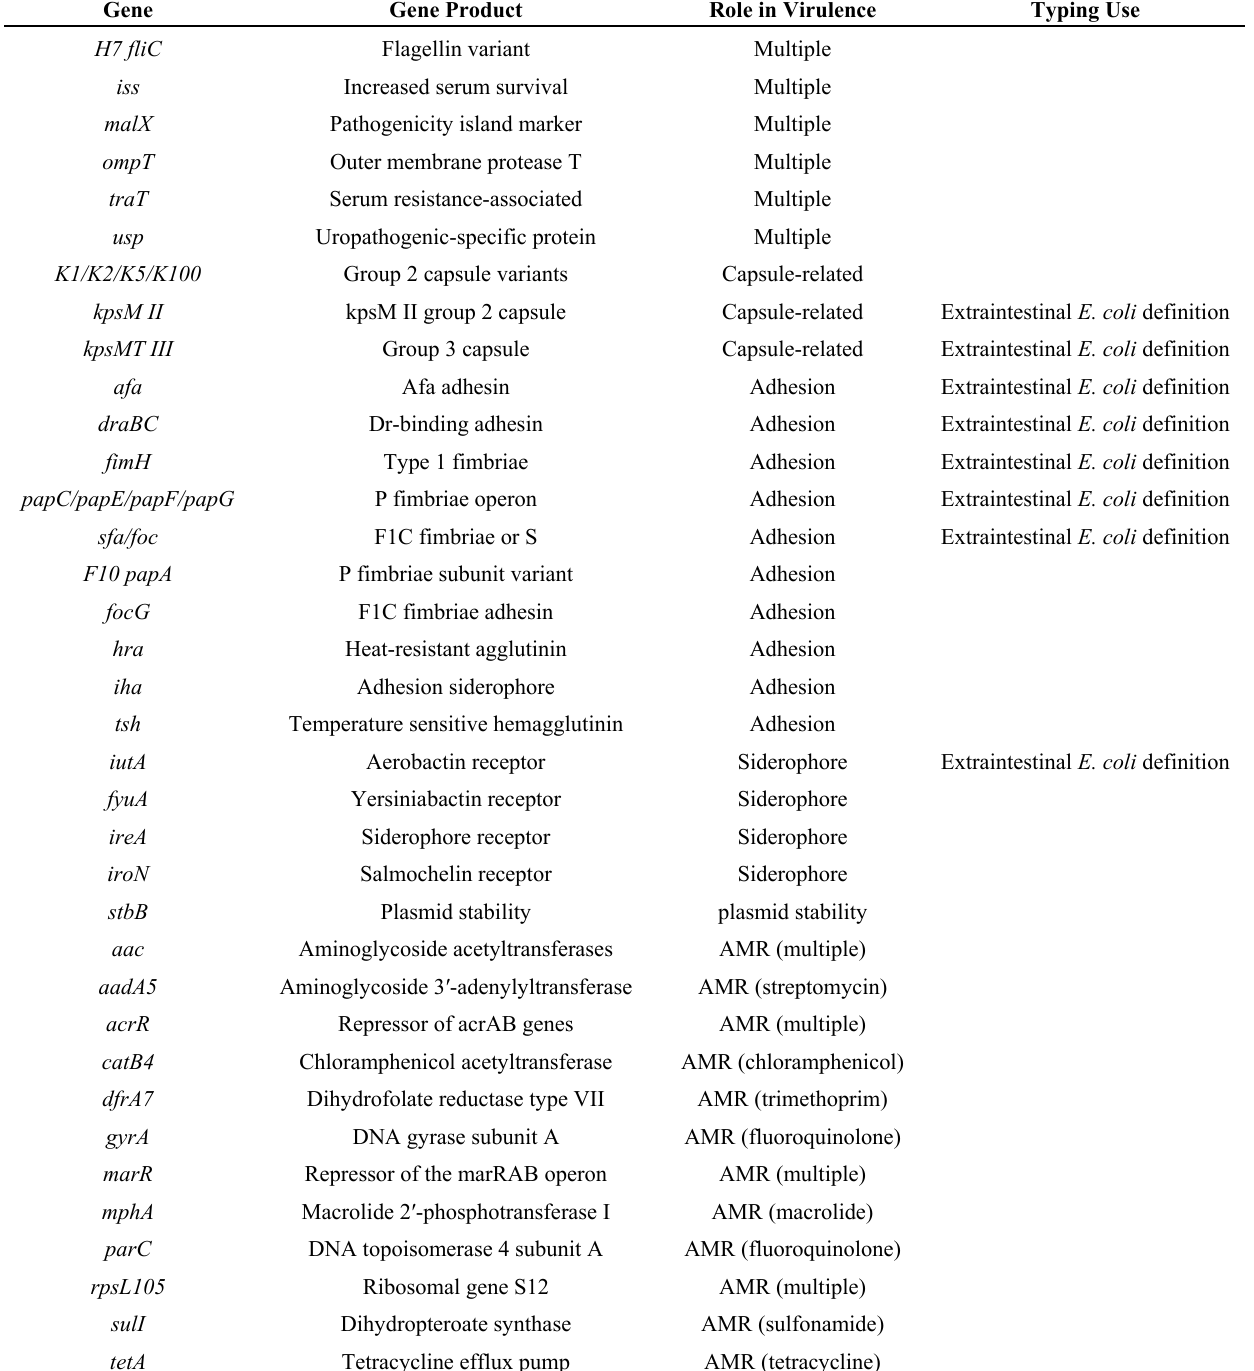
Table 1. Genes associated with virulence or ST131 typing. Genes encoding virulence factors (adhesion, capsules, siderophores, antimicrobial resistance, also known as AMR, toxins) and used to define Extraintestinal E. coli , H30-Rx ST131 and the Pasteur/Achtman multi-locus sequencing typing (MLST) schemes are